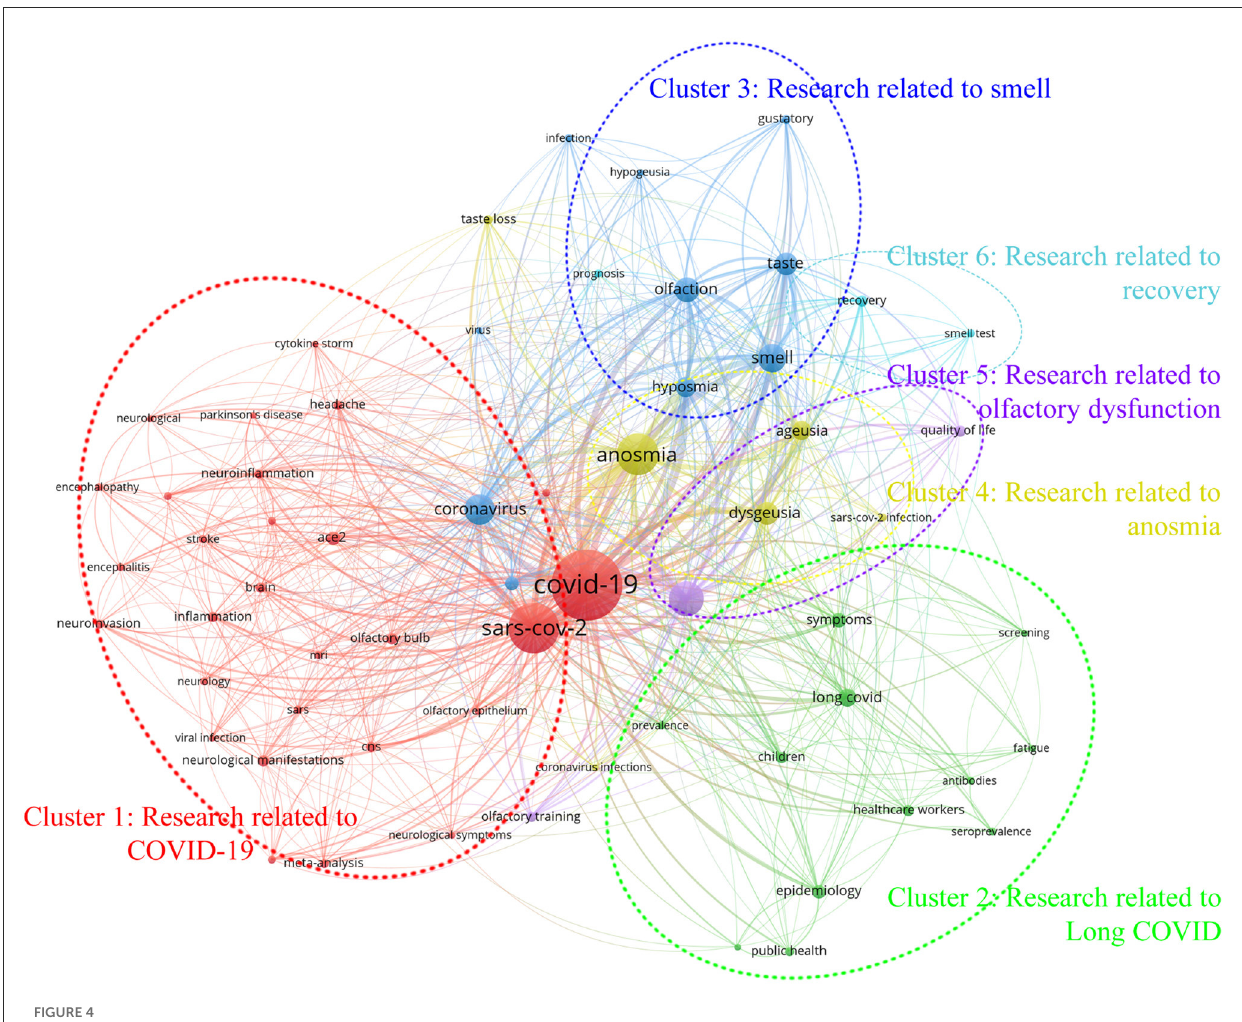
FIGURE4 The mapping of author keywords co-occurrence analysis.